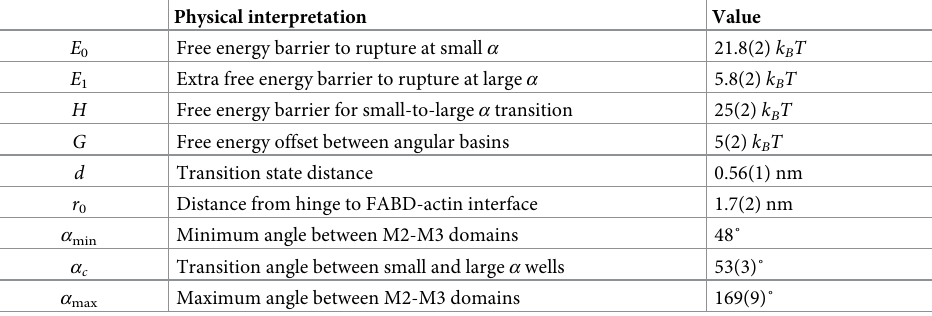
Table 1. Model parameters. Parentheses after the values denote the uncertainty in the last